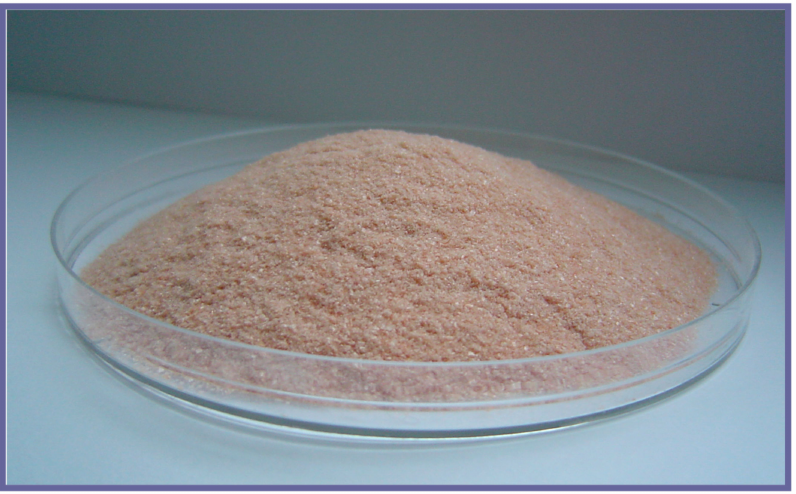
Figure 5. Lactoferrin (BLTF) isolated from bovine